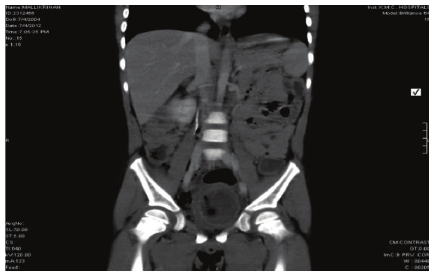
Figure 1: Contrast CT showing di ff use thickening of the right posterolateral bladder wall.